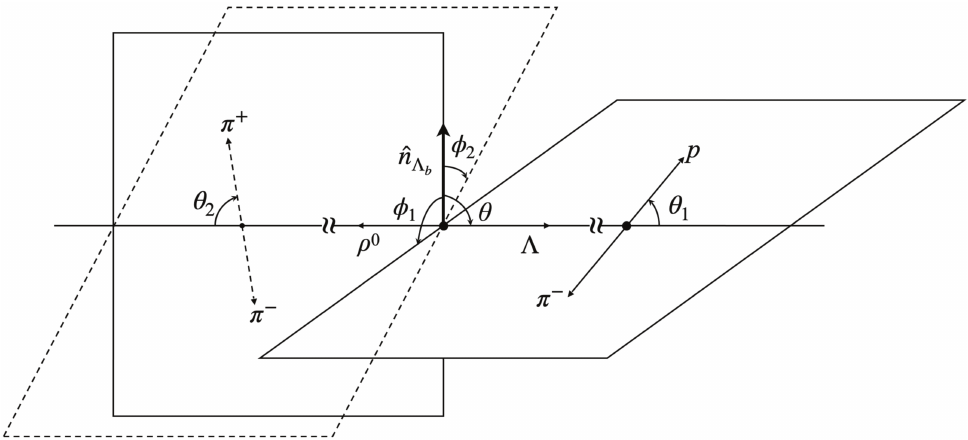
is the unit vector in the Λ polarized direction. b b depend on the angles, P → Λ ρ 0 , and D i b b